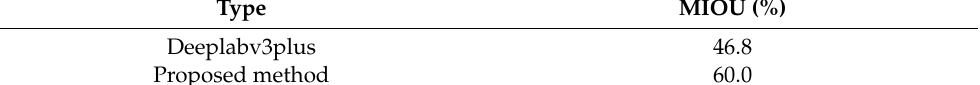
Table 6. The comparison of the MIOU between the standard deeplabv3plus with RESNET-18 and the proposed method.